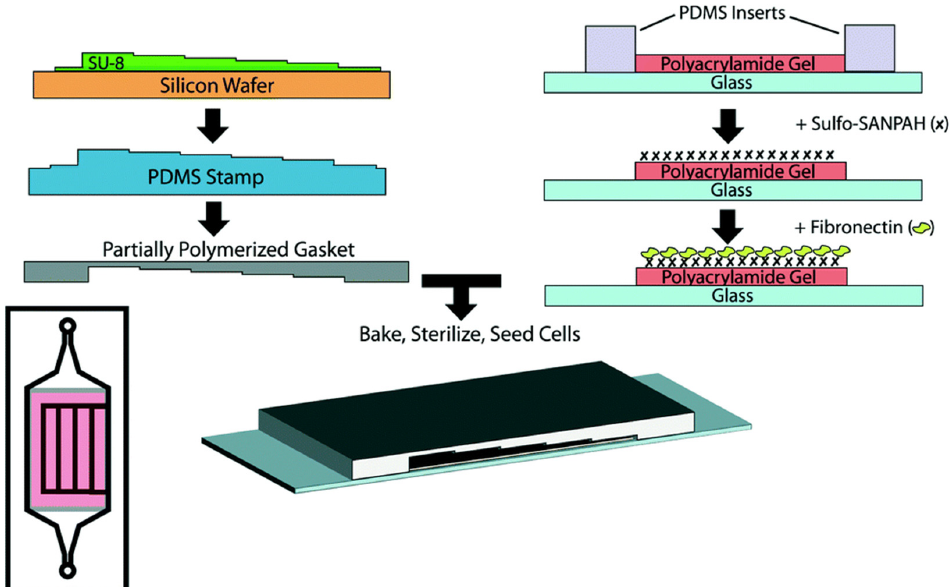
Figure 3. Fibronectin-functionalized PAM hydrogels with varied substrate stiffnesses for cellular responses . Device manufacture and preparation: The PDMS step gasket is developed and then ad- hered to a coverslip to make a rectangular-shaped PAM hydrogel coated with fibronectin. (Re- printed/adapted with permission from Ref. [37], Galie et al.).